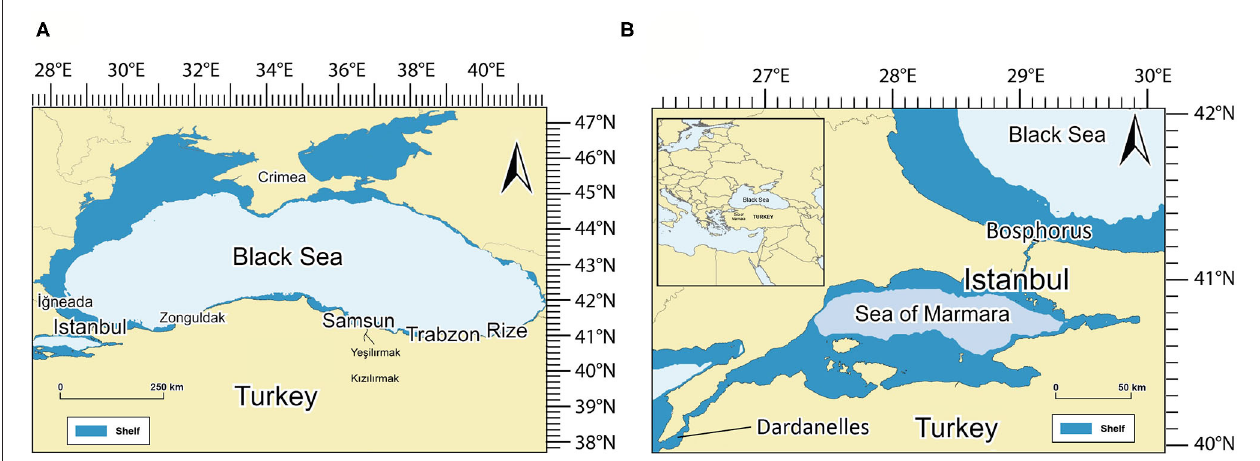
FIGURE 1 | (A) Black Sea and (B) the Sea of Marmara with the Bosphorus and Istanbul in the Northeast and the Dardanelles Strait in the Southwest, also displaying some cities and rivers mentioned in the text, with latitude and